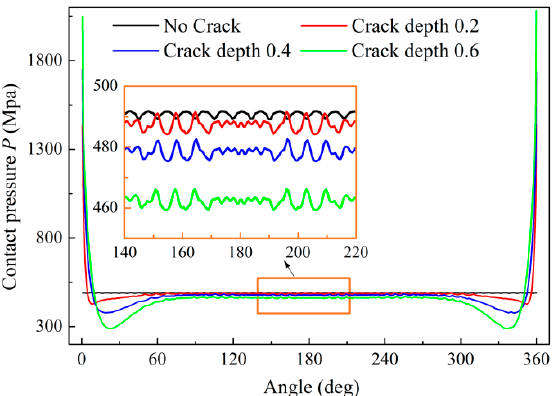
Figure 4. Contact pressure of cylinders with crack ( R 3 = 15 mm).